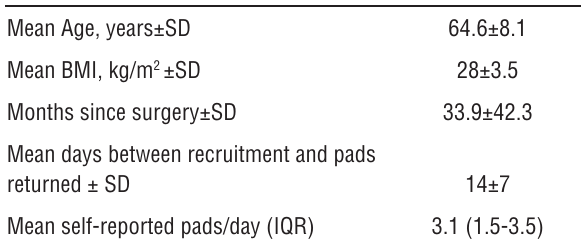
Table 1 - patient